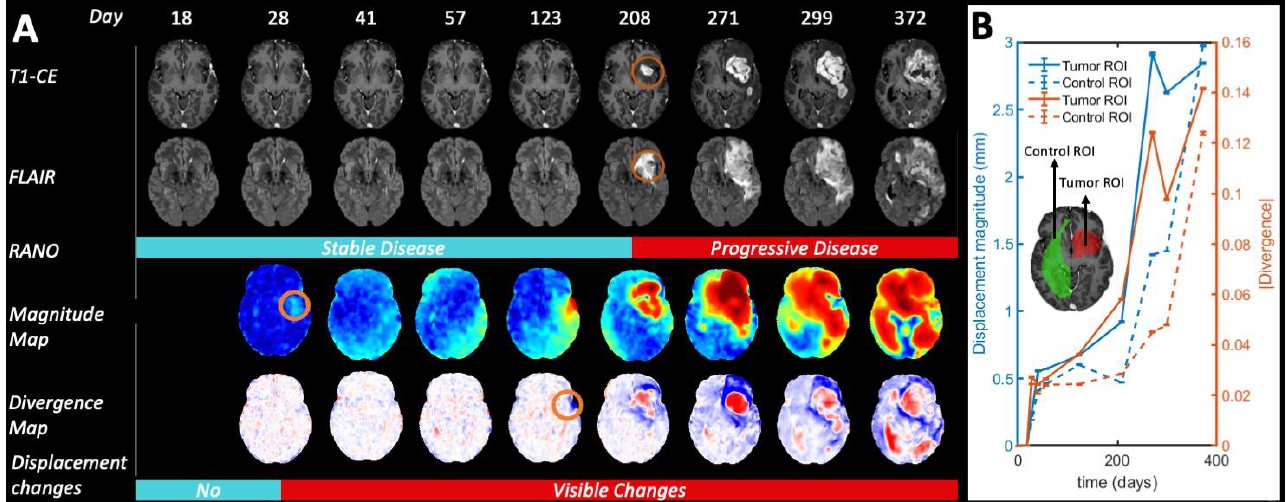
Figure 2. Longitudinal evolution of Patient 4 from day 18 after start of radio-chemotherapy treatment to day 372. For illustration purposes, we did not exclude the first MRI exams with periods shorter 30 days from the previous one in this figure, as described in the inclusion criteria for the rest of the statistical analysis. ( A ) According to RANO criteria, tumor progression started on day 208. However, the displacement maps show significant deformations already at day 28. Circles in orange highlight preliminary visual evidence of tumor growth. ( B ) Quantification of the displacement magnitude and absolute divergence in control and tumor ROIs, respectively.